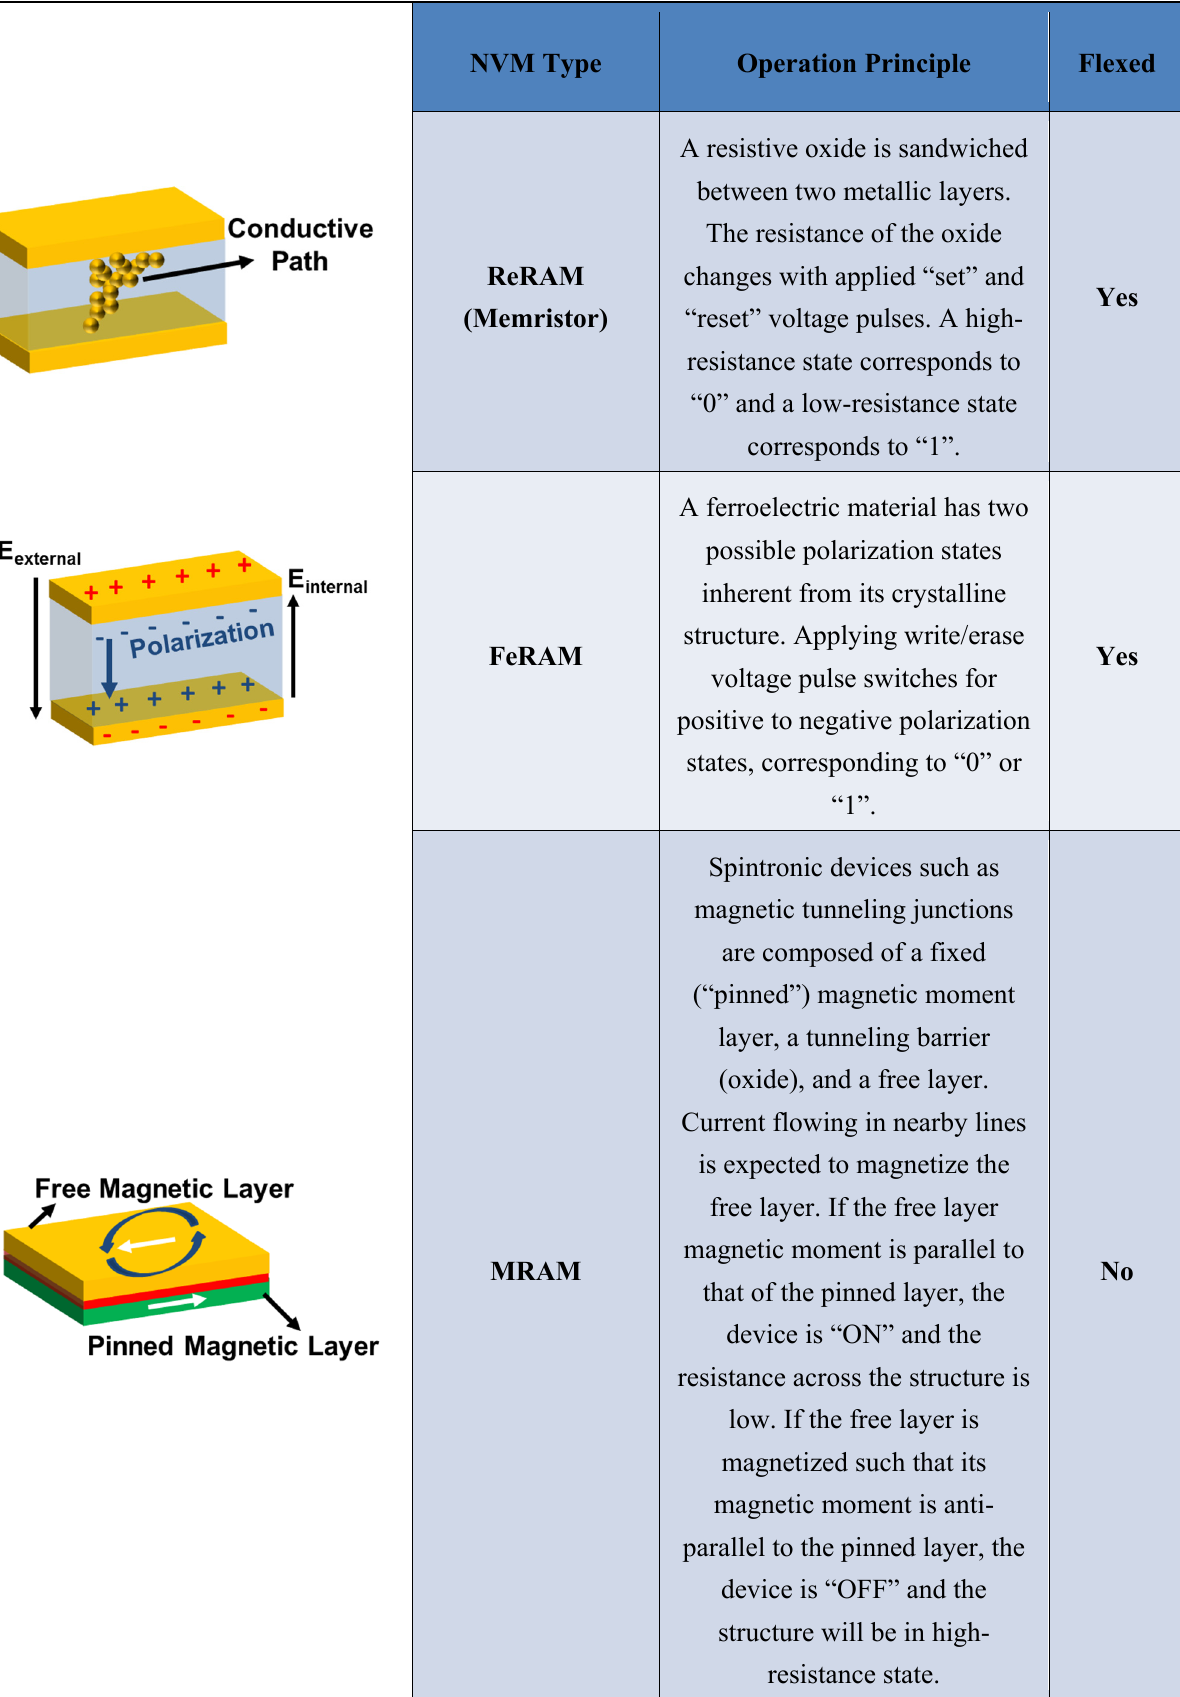
Table 1. Summary of non-volatile memory technologies and indications of flexed